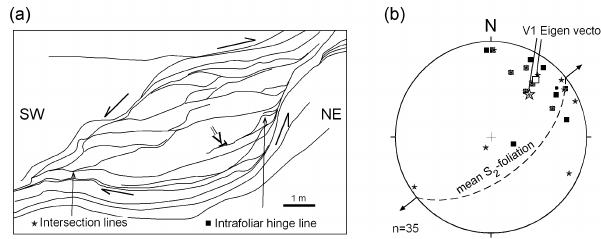
Figure 8. Relation of deformation structures inside and outside lozenge migmatitic bodies: (a) sketch showing the trace of the S 2 foliation in bounding shear zones and within the lozenge (location of observations in Fig. 4c); and (b) pole figure of main S 2 foli- ation, intersection lineation and intrafolial hinge lines within the lozenge in (a) . Equal area projection, lower hemisphere projection also shows the V1 eigenvector and the mean S 2 -foliation plane. The arrows indicate the orientation of the horizontal maximum exten- sion